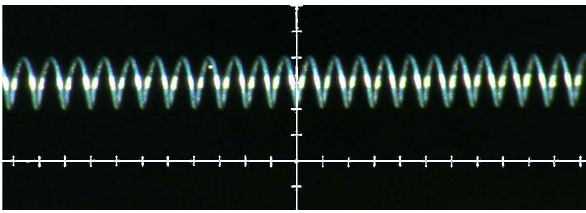
Fig. 1. Microscope photograph of the temperature sensor made of a tungsten wire of 10µm in diameter wound up in a helical coil with the diameter of 200µm and the pitch of 100µm. Tick marks on the scale in every